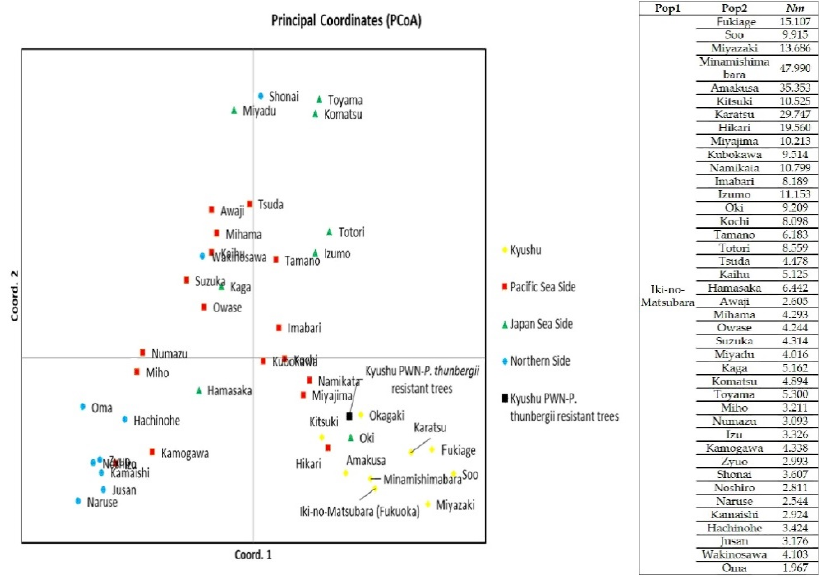
Figure 2. PCoA of Iki-no-Matsubara with other populations of P. thunbergii and the Kyushu PWN- P. thunbergii resistant trees with gene flow ( Nm ) between Iki-no-Matsubara and the other populations.